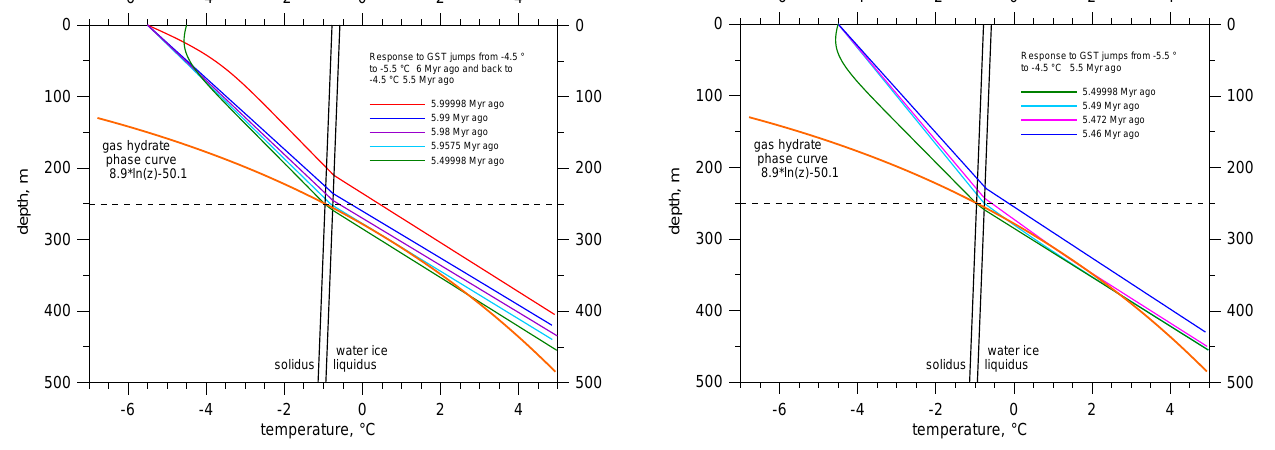
Fig. 7. Case 2 transient temperature-depth profiles illustrating the response to the sudden GST warming from -5.5 °C to -4.5 °C at 5.5 Myr ago and to all previous GST changes since 14 Myr ago. The profiles correspond to times 20, 10 000, 28 000 and 40 000 years after the warming begins. The curve for time 28 000 years (5.472 Myr ago) shows the moment when the last GH disappears in the depth interval 310 – 340 m, when it is separated from the IBP base (240 m) by a 70 m thick melted zone.